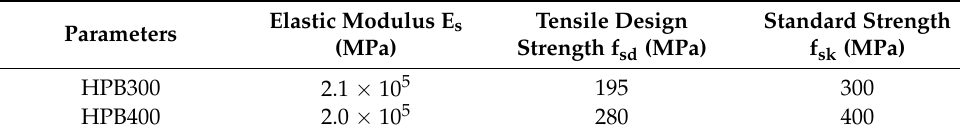
Table 2. Properties of reinforcement used in this study.